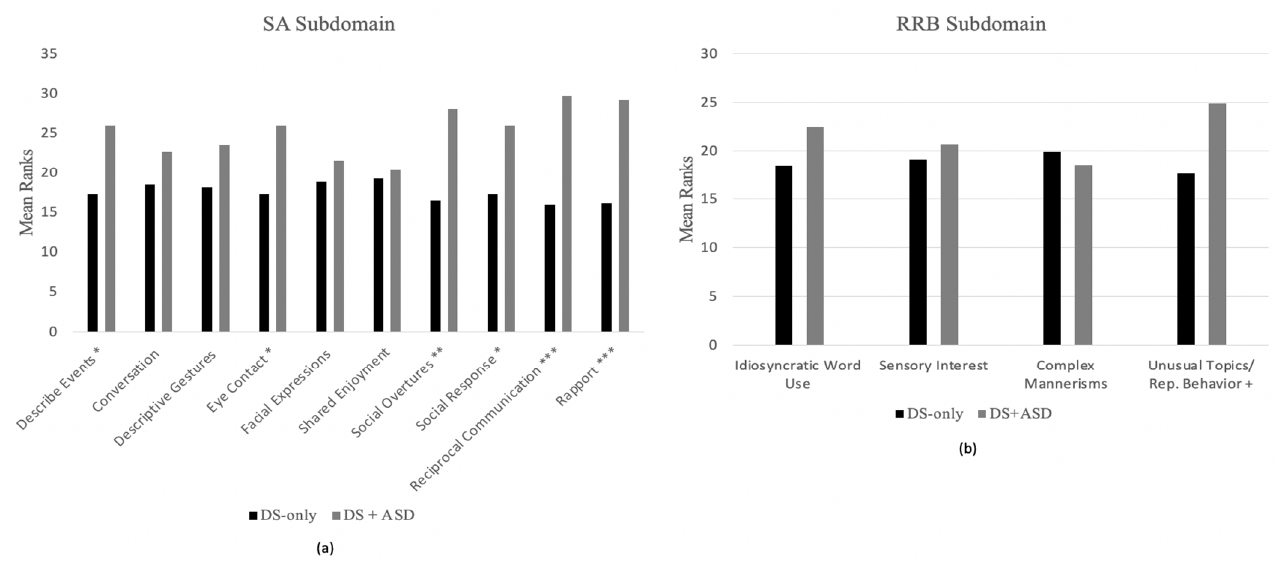
Figure 4. Mean Rank comparisons for Module 3 algorithm items; ( a ) Mean Rank comparisons for Module 3 SA items; ( b ) Mean Rank comparisons for Module 3 RRB items. Note: * p < 0.05; ** p < 0.01; *** p < 0.001; + signifies no longer significant after FDR correction.